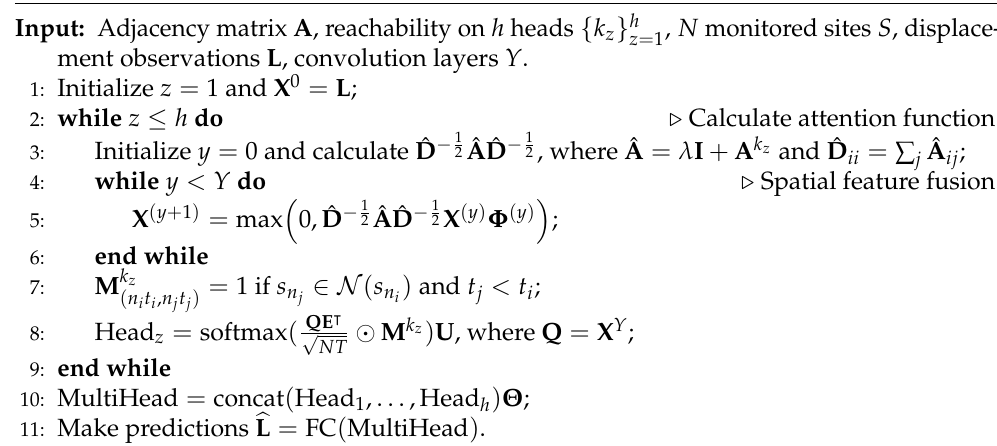
Algorithm 1 Predicting via